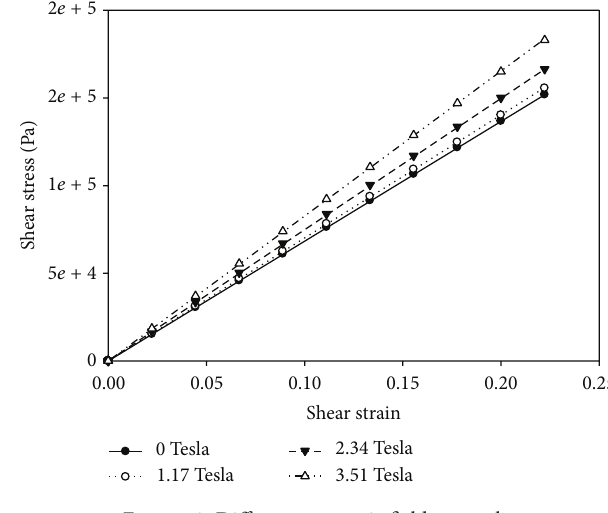
Figure 9: Different magnetic field strength.